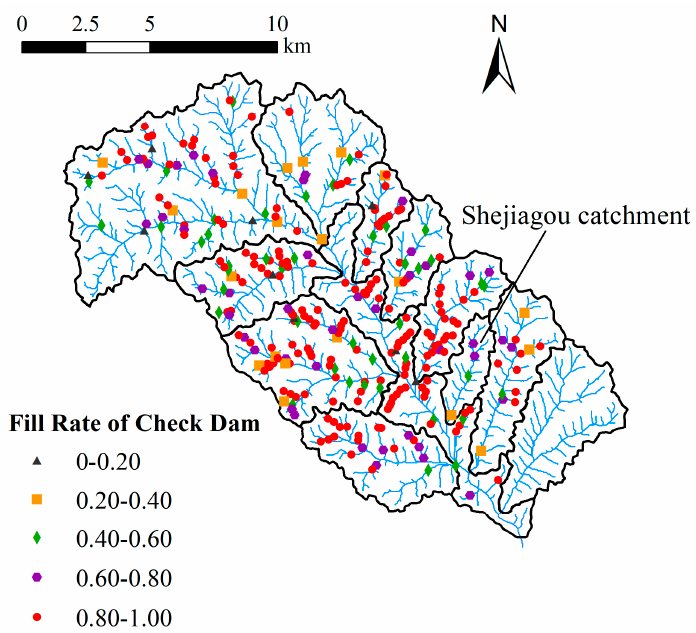
Figure 9. Fill rate of check dams in the Chabagou watershed. Note that when the check dam is filled, its fill rate equals to 1.